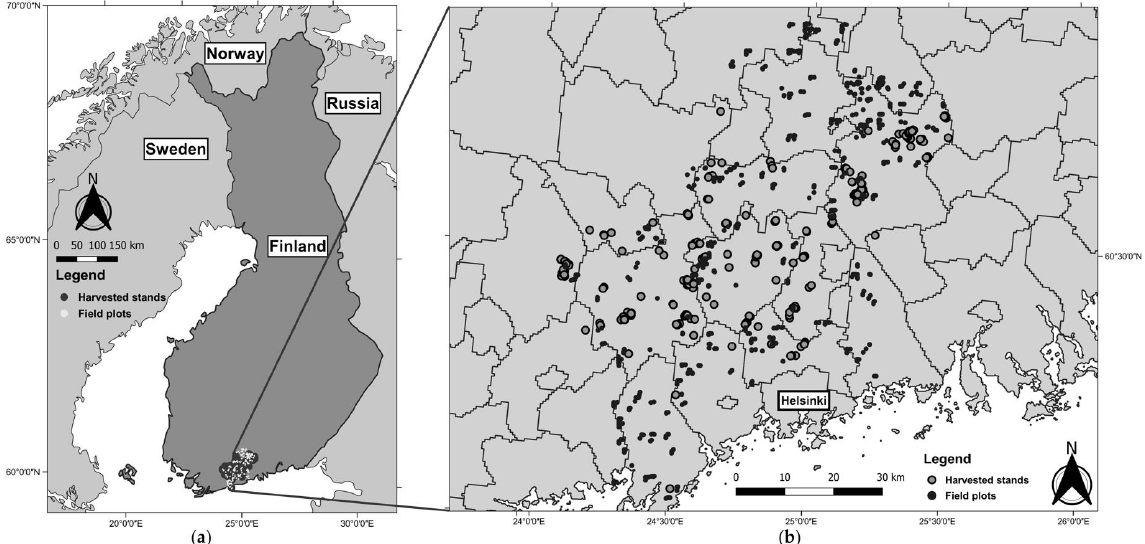
Figure 1. ( a ) Location of the area of Southern Finland studied; ( b ) the harvested stands (grey circles) and the field plots (black circles) investigated.